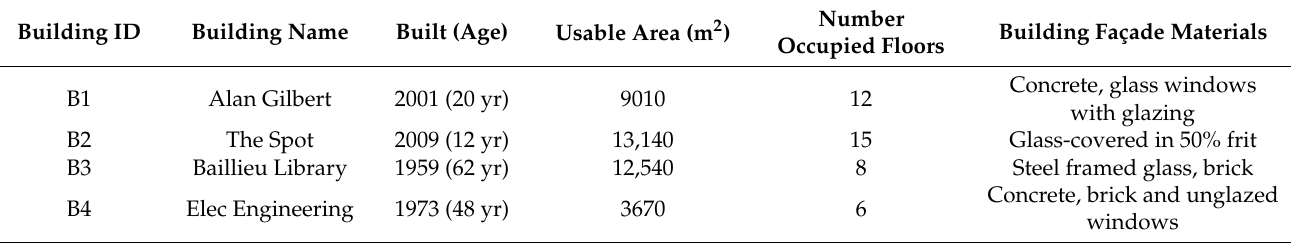
Table 2. Comparative summary of buildings selected for case